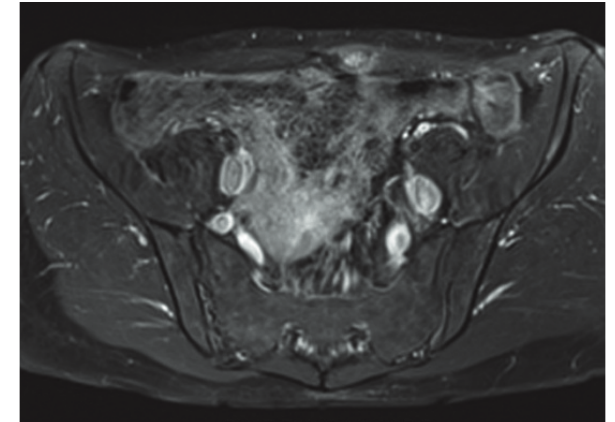
Fig. 3. Axial post-Gd T1-weighted image through